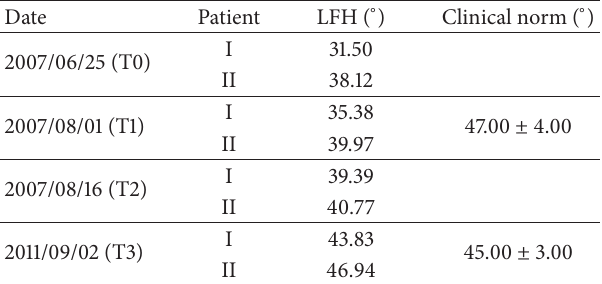
Table 1: Cephalometric data. Lower face height from the Ricketts lateral cephalometric analysis (LFH), at baseline (T0), trial insertion (T1), after installation and final adjustments of complete dentures (T2), and four years later